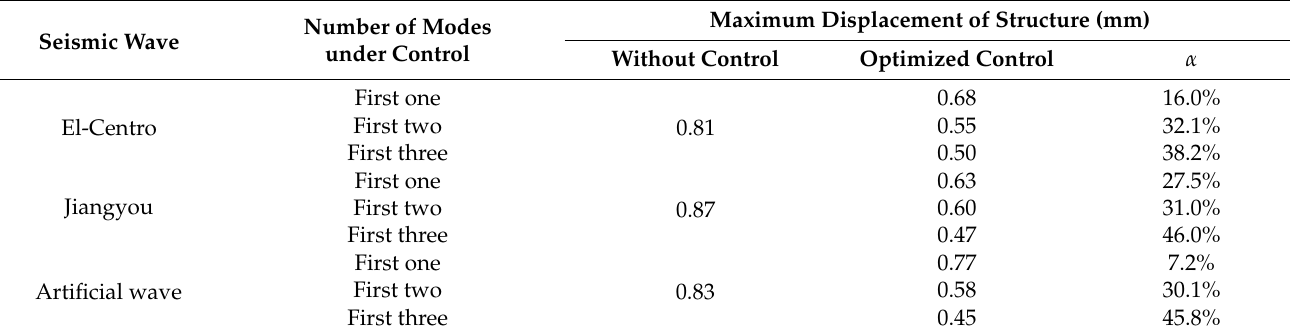
Table 10. Comparison of the optimal control acceleration with